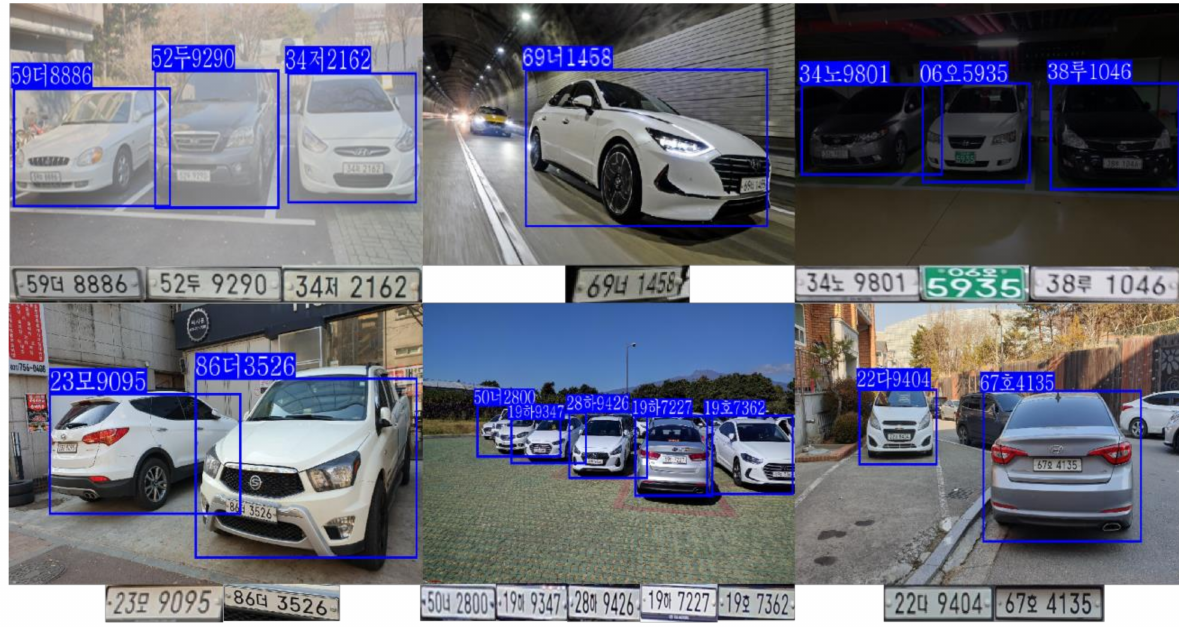
Figure 10. Different LP templates were detected and recognized correctly under foggy and dark environments and at different angles, such as the back side, front side, left side, and right side.